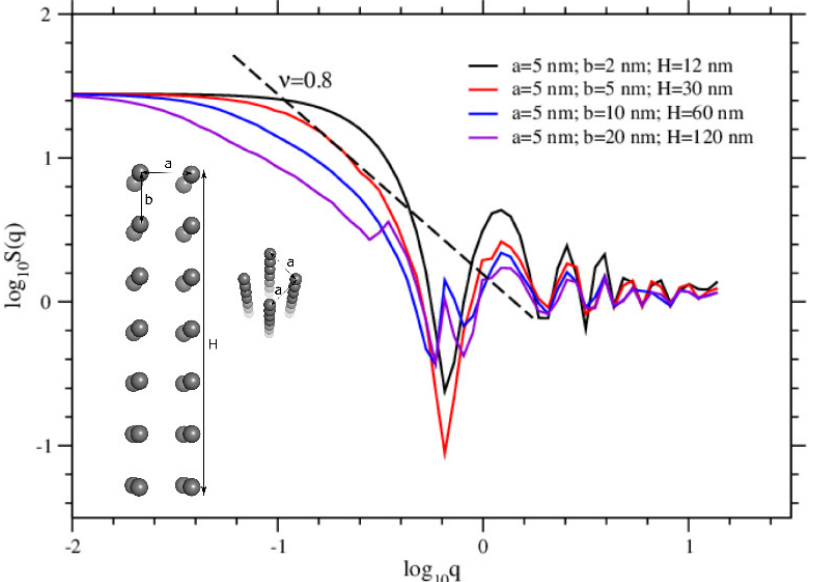
Figure 10. Structure factors are calculated for hand-drawn tubular structures of various sizes. The sizes are shown inside the figure. The sizes of the curve in red correspond to the structures obtained from the simulations. The straight dashed line shows the asymptotic scale, which is ν =